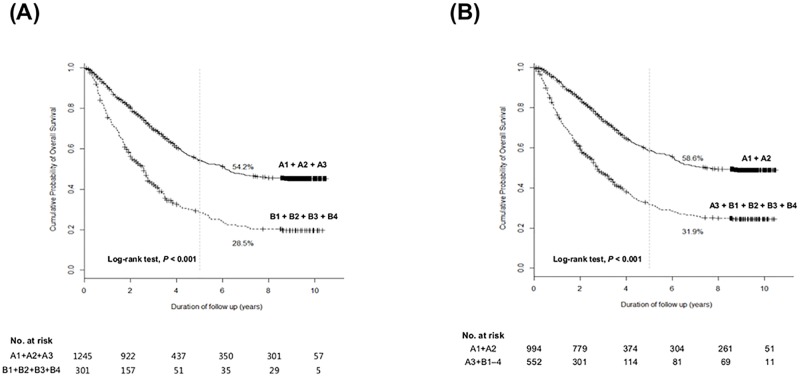
Cumulative overall survival rate of each subgrouping when other intermediate tumors (B2–B4) were taken into consideration.(A) Overall survival rates according to subgrouping ‘A1–A3 vs. B1–B4’ (B) Overall survival rates according to subgrouping ‘A1–A2 vs. A3–B4’.